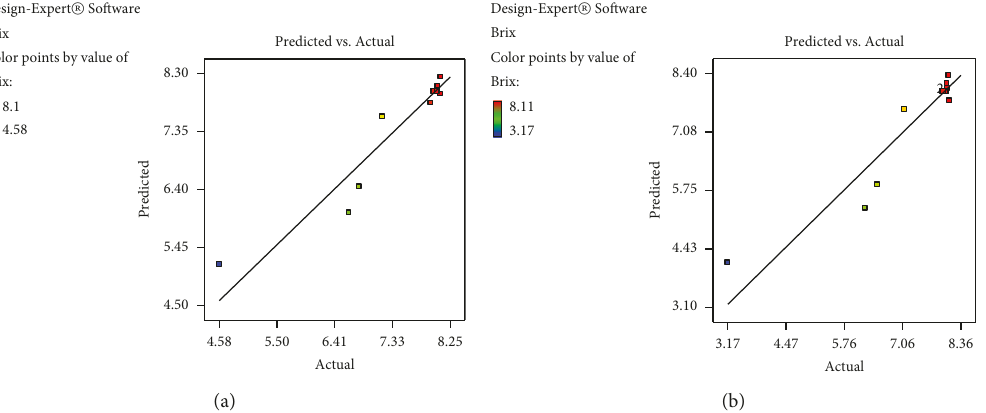
Figure 5: Actual vs predicted values of Brix in the malting process.